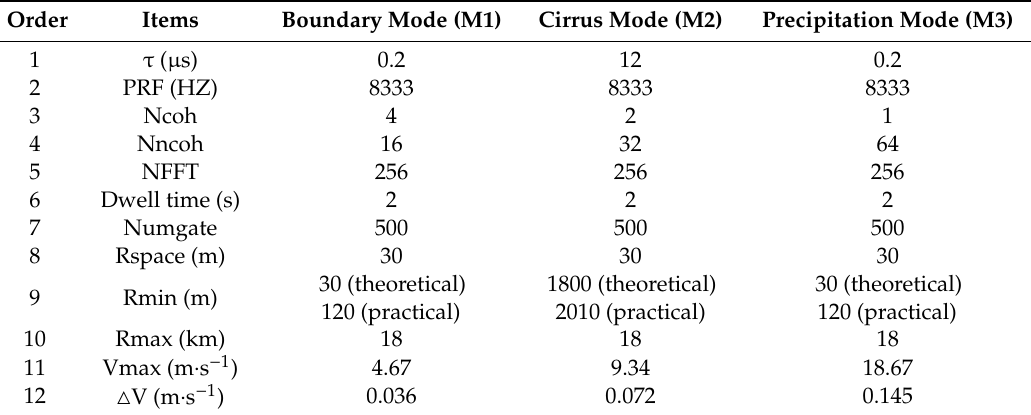
Table 2. Major operational parameters for the three operational